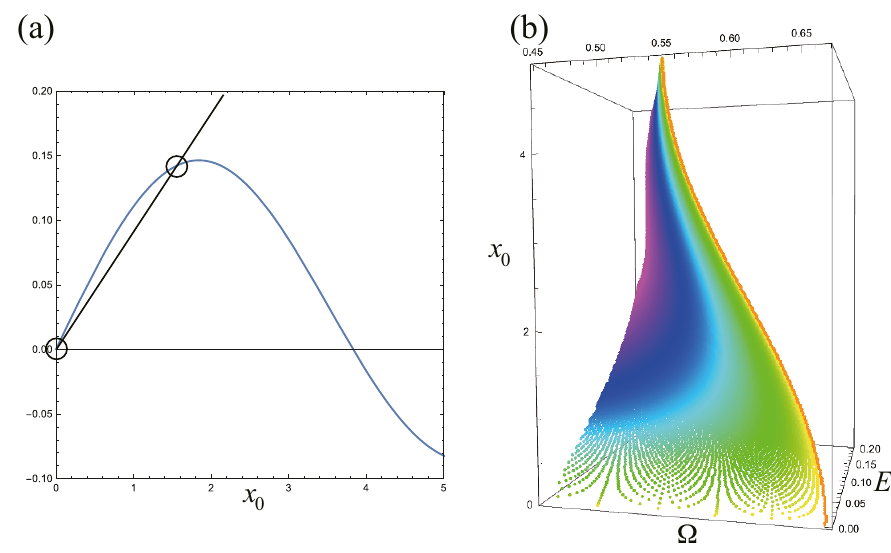
Figure 15 . Analysis of the toy model: (a) The left and right hand sides of the equation (7.5), giving multiple solutions denoted by circles for zero (cid:12)eld E = 0. Note that the numerical constant c is set to unity. (b) The surface of solutions. The orange line corresponds to solutions at E = 0. (cid:6) (cid:25) 1 = 2 . Due to the quadratic potential, such excitation will be energetically suppressed